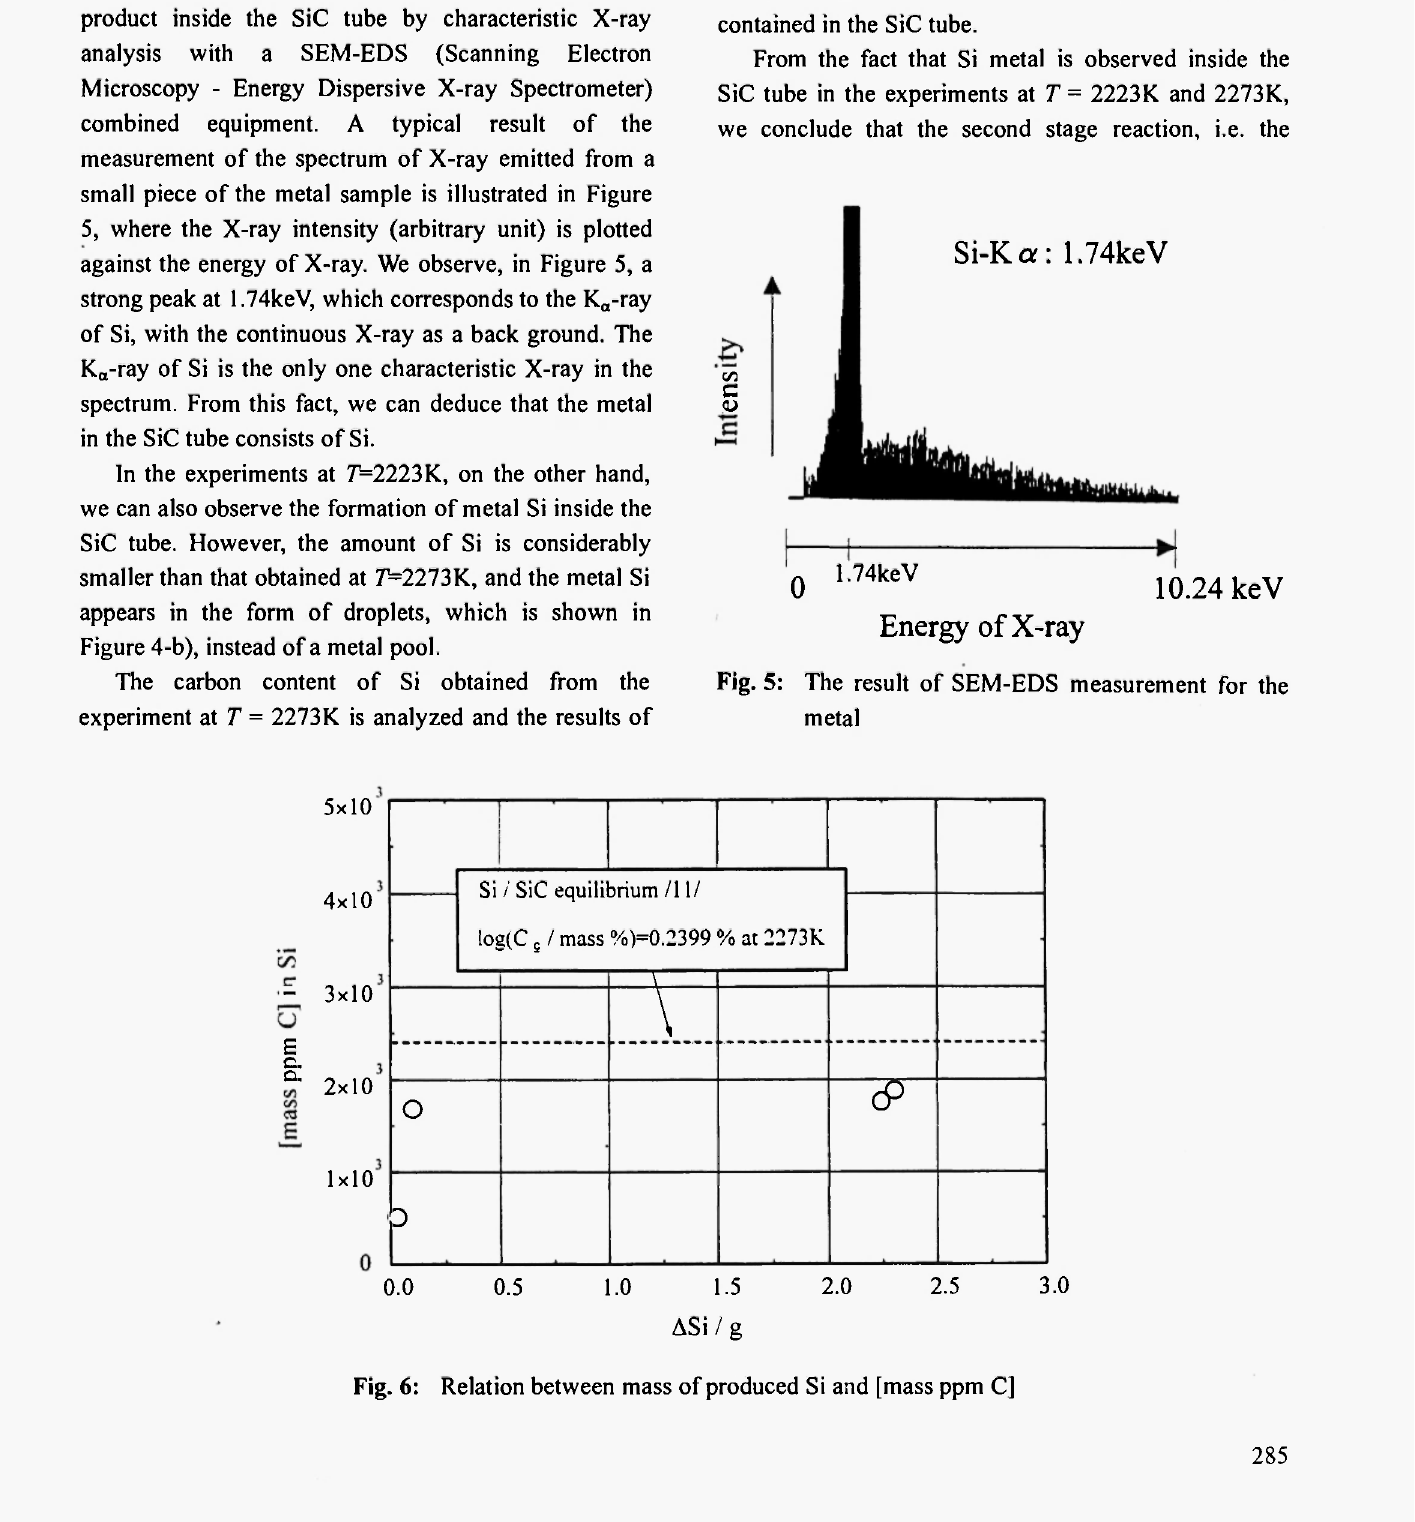
Fig. 6: Relation between mass of produced Si and [mass ppm